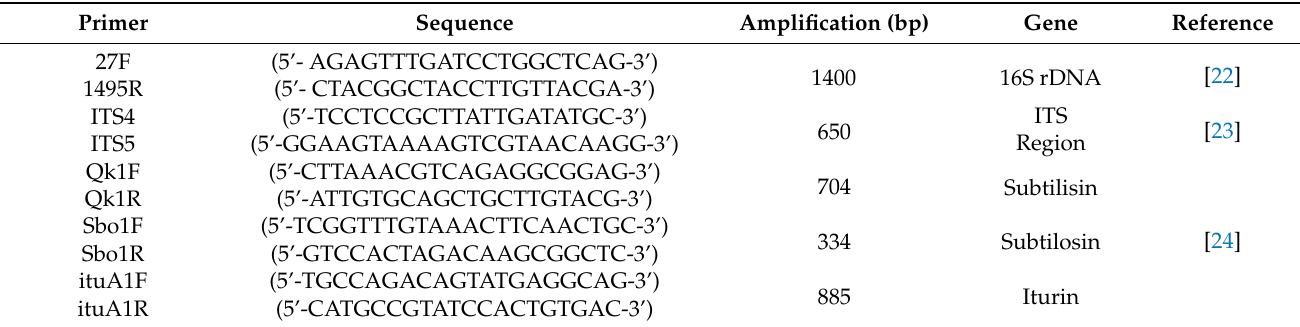
Table 1. Primers used in the present